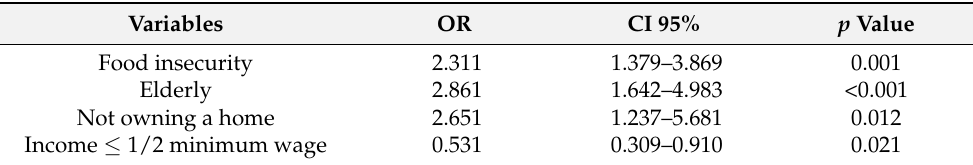
Table 3. Final logistic regression model of the association between anemia, food insecurity classified by the Brazilian Food Insecurity Scale (EBIA), being elderly, income and housing characteristics of rural households in a municipality of Brazil. Variables OR CI 95% p Value Food insecurity 2.311 1.379–3.869 0.001 Elderly 2.861 1.642–4.983 <0.001 Not owning a home 2.651 1.237–5.681 0.012 Income ≤ 1/2 minimum wage 0.531 0.309–0.910